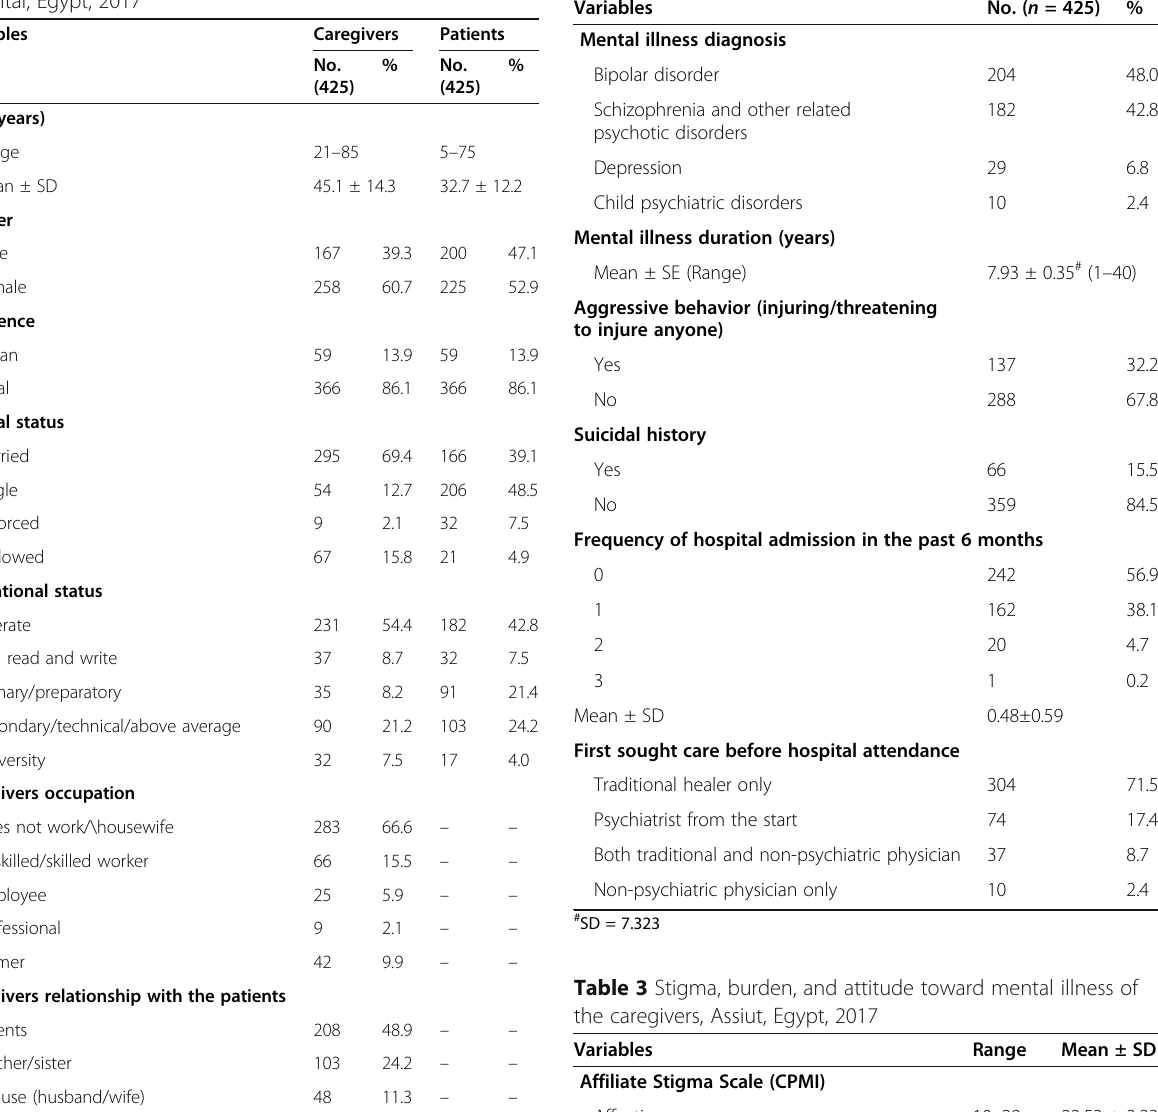
Table 2 Medical history of the studied mentally ill patients,